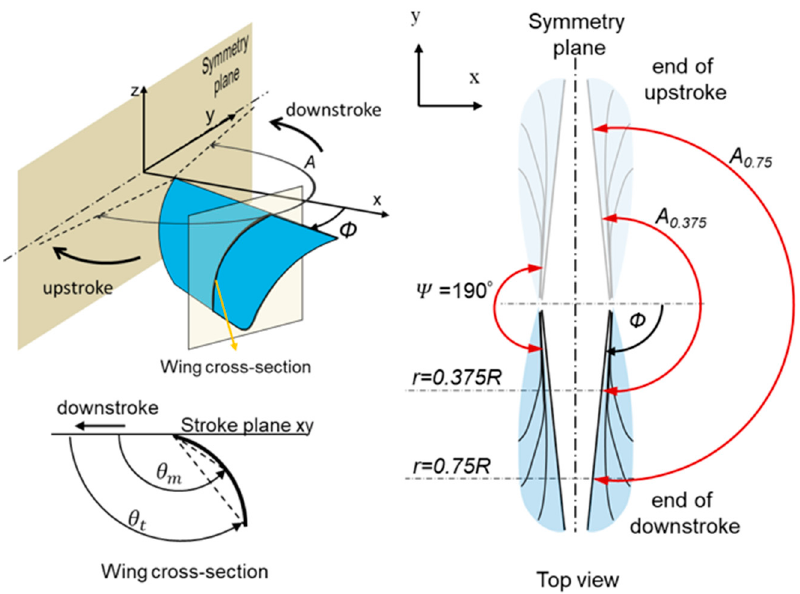
Figure 1. Schematics of the flapping wing motion of the KUBeetle.